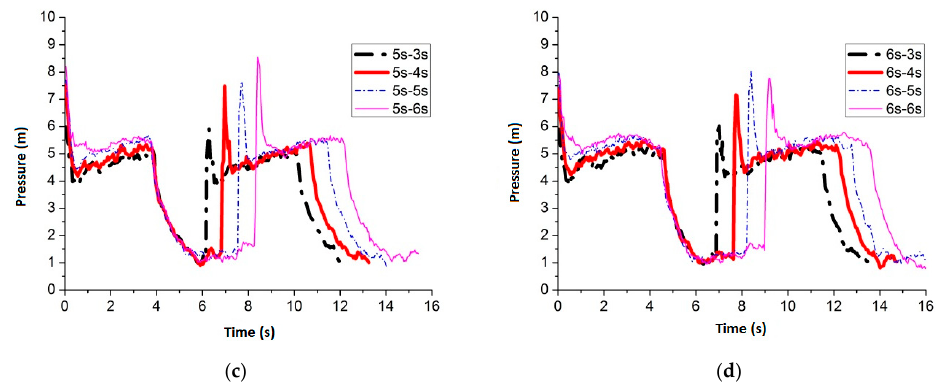
Figure 15. Pressure fluctuation of No. 1 sensing point (rectangular nozzle on top of the pipe): ( a ) air inflow time is 3 s; ( b ) air inflow time is 4 s; ( c ) air inflow time is 5 s; and ( d ) air inflow time is 6 s.